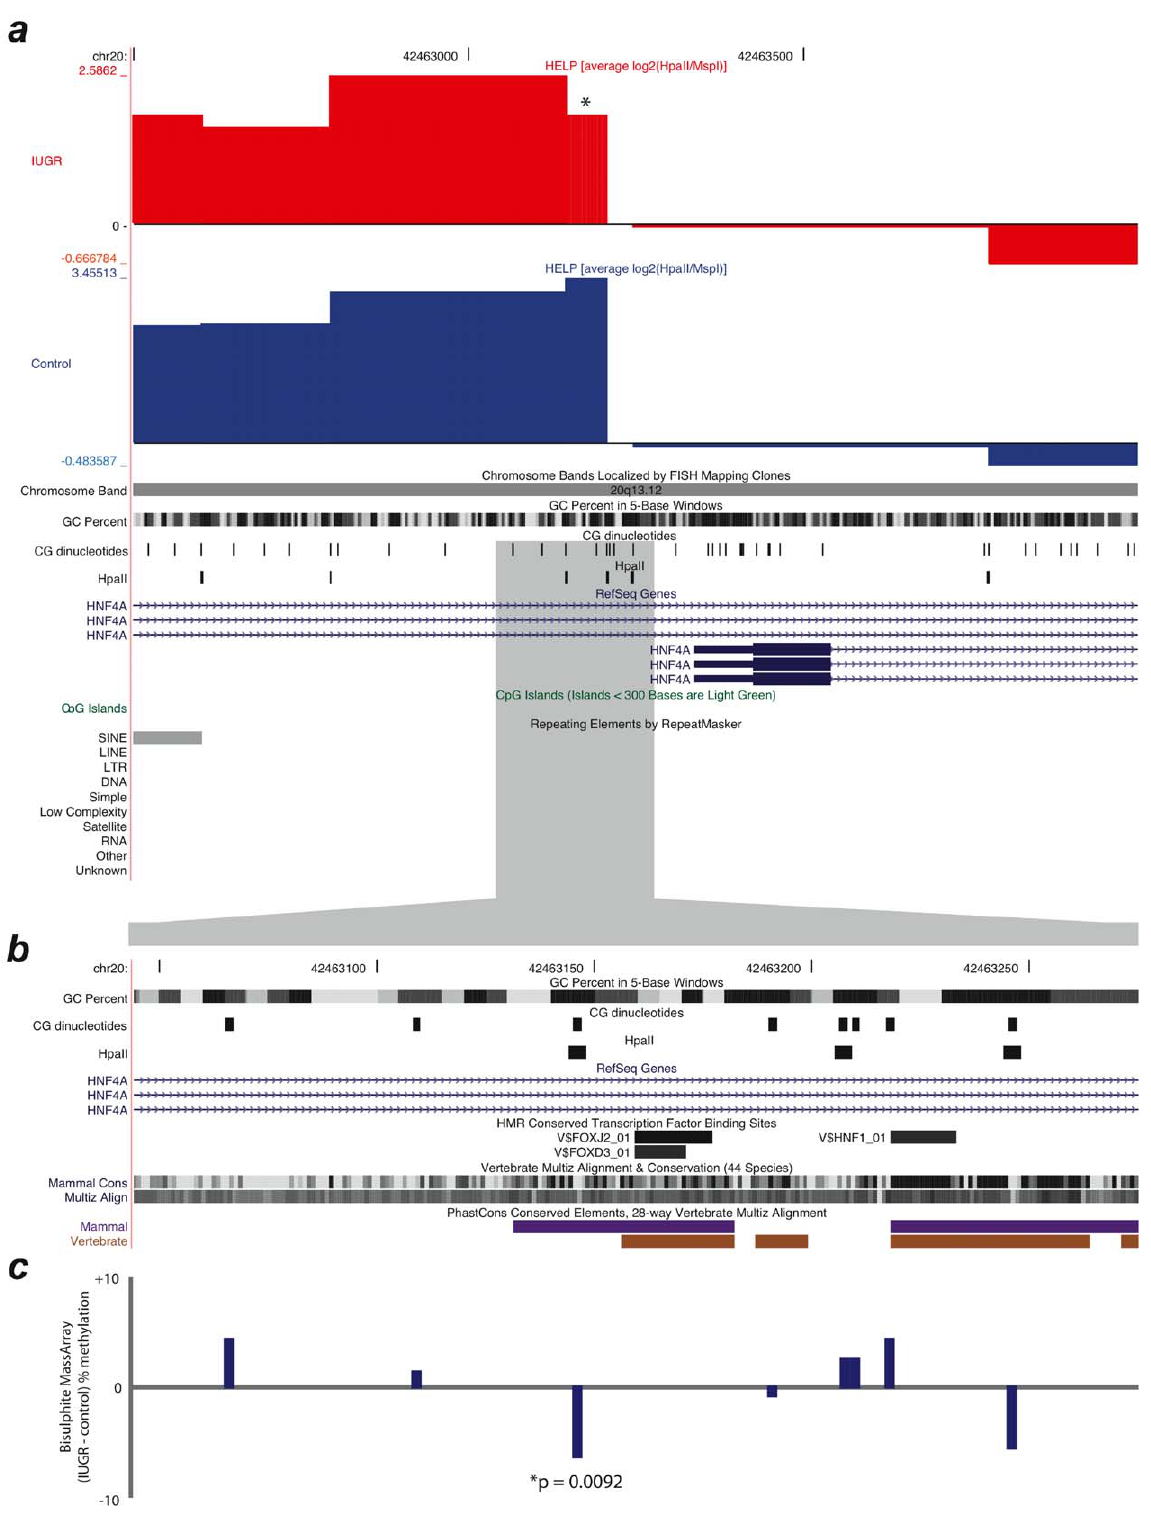
Figure 3. Differential methylation at the HNF4A locus proximal promoter region. HELP data are shown in (a) as normalized, centered log 2 (HpaII/MspI) ratios. A locus with a change in methylation is marked with an asterisk. A more detailed view of this region is shown in (b), showing conservation of DNA sequences at this alternative promoter of HNF4A . In (c) the degree of difference in cytosine methylation as measured by bisulphite MassArray is shown with the locus changing to a significant degree shown with its associated p value. This CG dinucleotide is within one of the HpaII sites of the informative gragment in (a) and is located immediately beside the conserved transcription factor binding sites shown in (b). These images were derived from the UCSC Genome Browser [60].